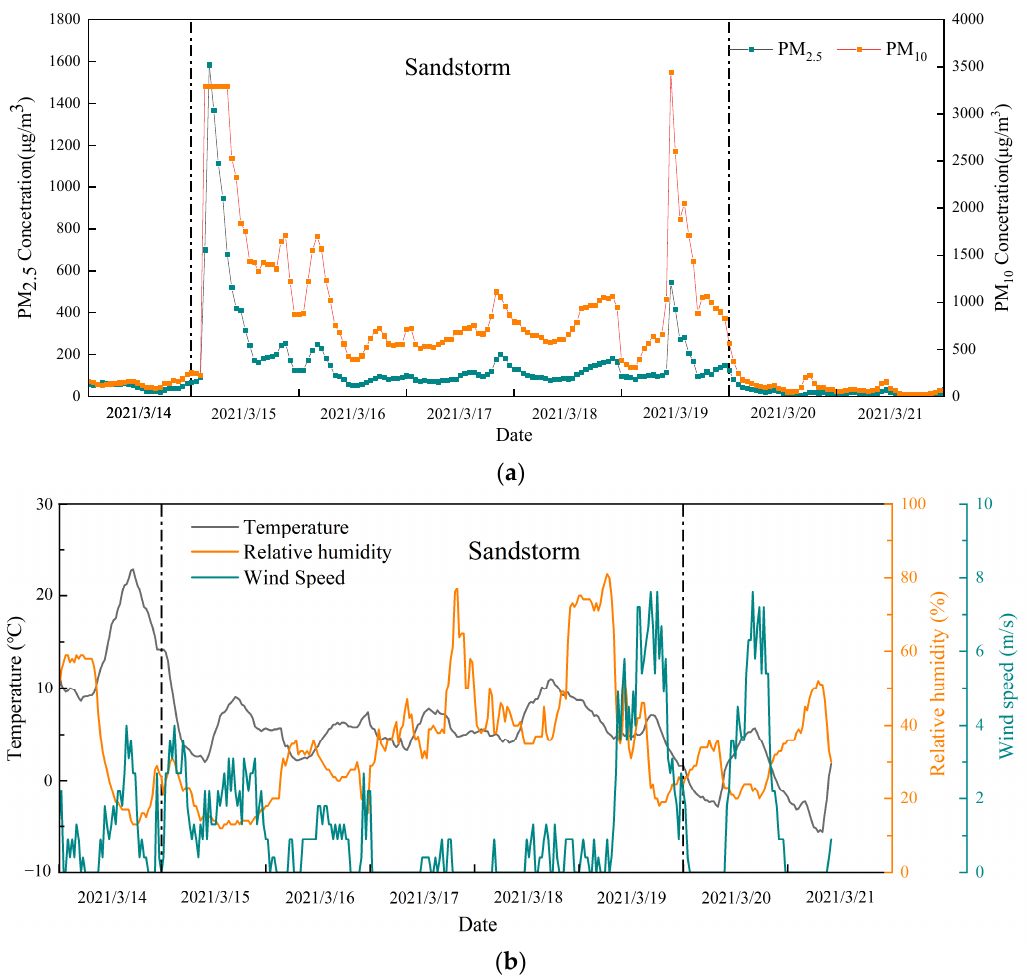
Figure 3. ( a ) Daily change of PM 2.5 and PM 10 concentrations in Wuhai during the sandstorm; ( b ) changes of meteorological conditions in Wuhai during the sandstorm.